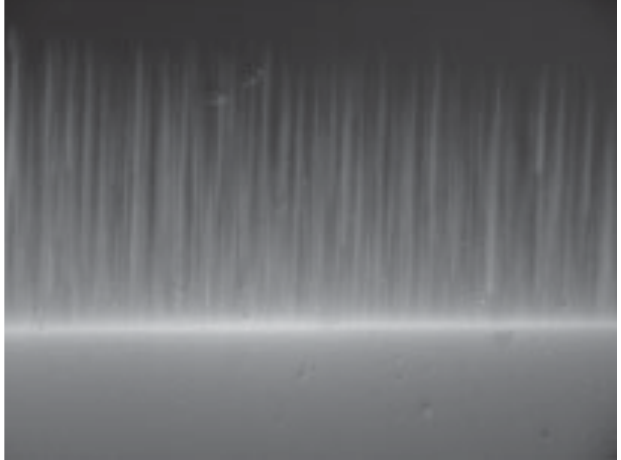
FIG. 2. (a) Direct and (b) differential magneto-optical images of flux penetration in a YBCO film on a (cid:2) ¼ 14 (cid:1) -tilted substrate. The applied magnetic field is B a ¼ 16 : 2 mT , and the sample temperature is T ¼ 4 K . The image brightness represents the distribution of flux density. In (b), the linear streaks show the avalanches taking place during (cid:1) B a ¼ 42 : 5 (cid:3) T . The white scale bars at the bottom of each panel are 200 (cid:3) m